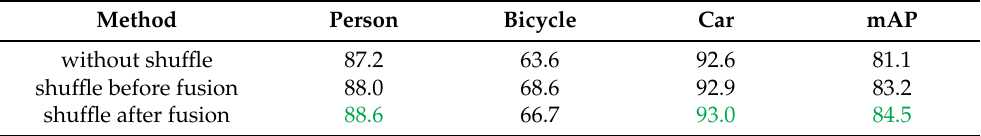
Table 8. On the FLIR dataset, object detection results at a single IoU of 0.50 when the shuffle is placed in different positions of Dual-YOLO. All values are in %.The top results are marked in